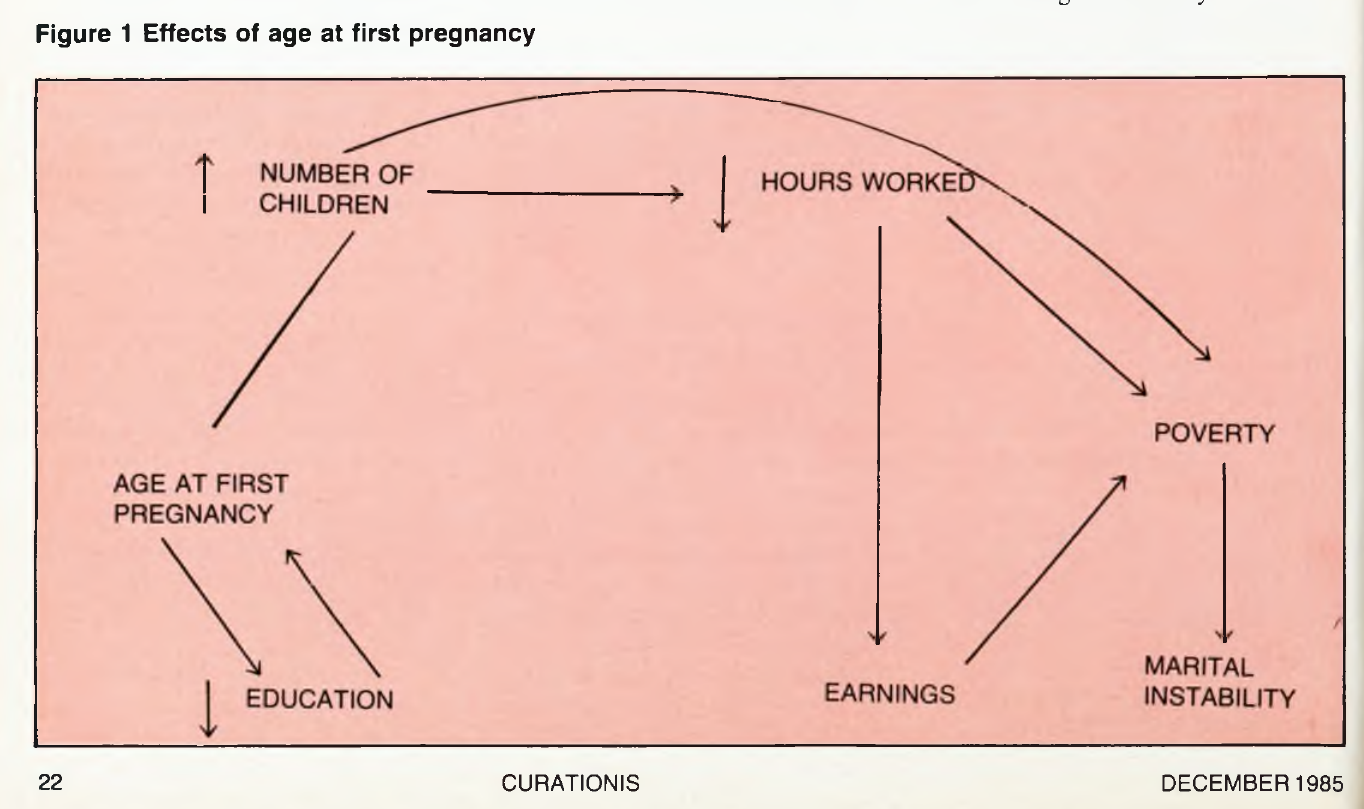
Figure 1 Effects of age at first